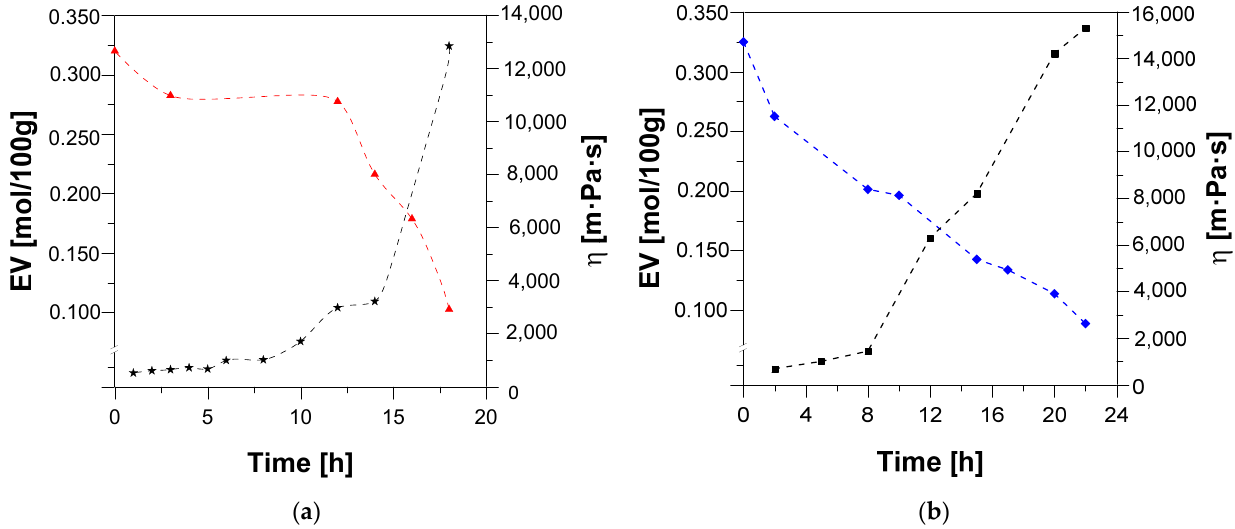
Figure 3. Change of EV and viscosity of the reaction mixture during the polyaddition process conducted in bulk via the fusion method: ( a ) ESBO_BPA and ( b ) SMEG_EPR.